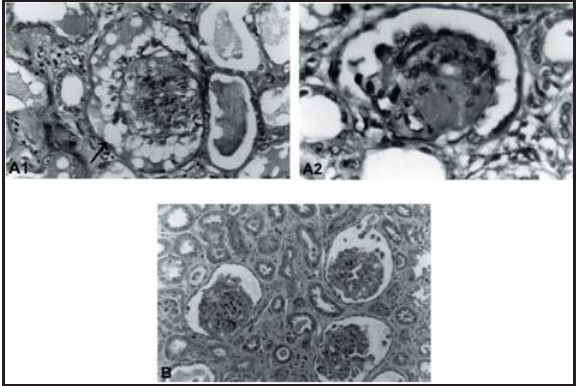
Figura 2 – Esclerose mesangial difusa. A1 – Glomérulo com proliferação mesangial. Podócitos vacuolizados ao redor do tufo glomerular ( (cid:111) ). Túbulos dilatados (caso 2,